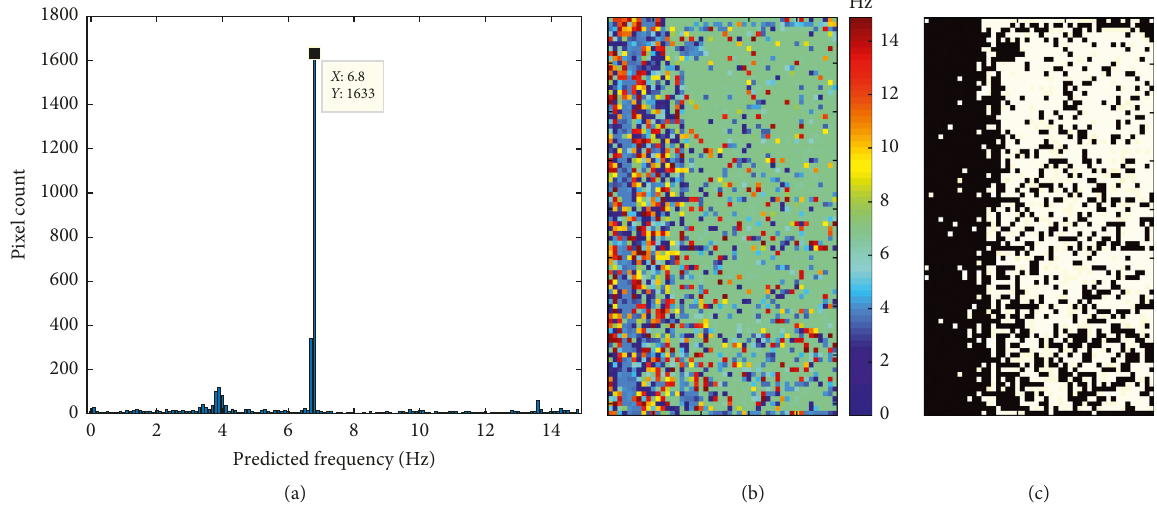
Figure 21: Simply supported carbon plate experimental case 1 result from the proposed method. (a) Histogram of predicted frequency distribution. (b) Predicted outputs visualization in their original spatial position. (c) Highlighted pixels predicted as 6.8 Hz for